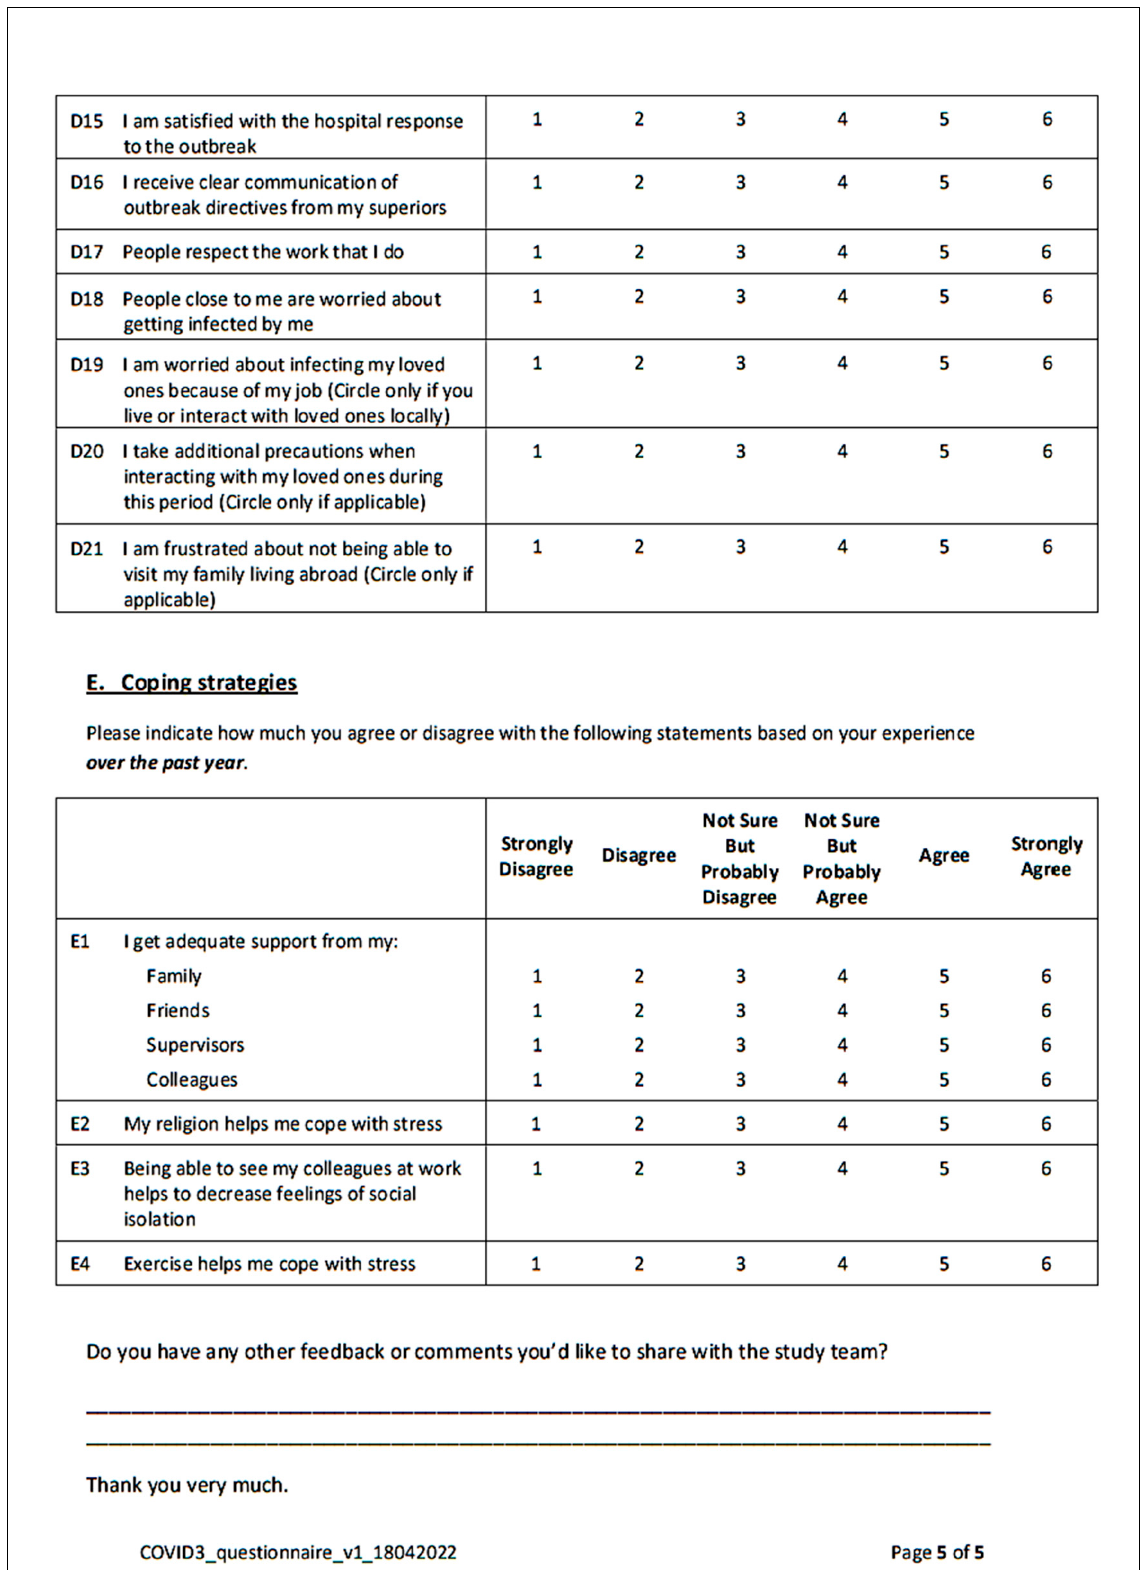
Figure A1. COVID-19 survey questionnaire for 2022.